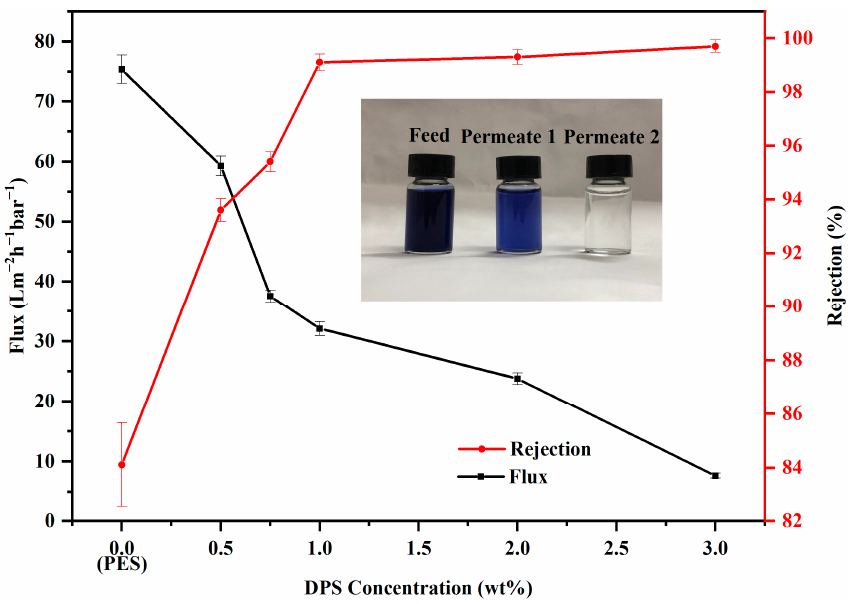
Figure 9. The e ff ect of DPS concentrations on NF performance of the prepared membranes (Feed: 0.2 g·L − 1 DB71 solution, Permeate 1: permeate by the PES support membrane, Permeate 2: permeate by the PES–DPS–1 membrane).